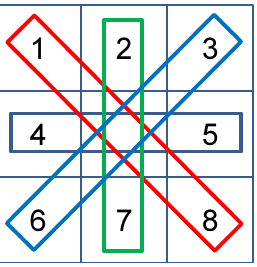
Figure 6. Pairings for calculating gradient angle